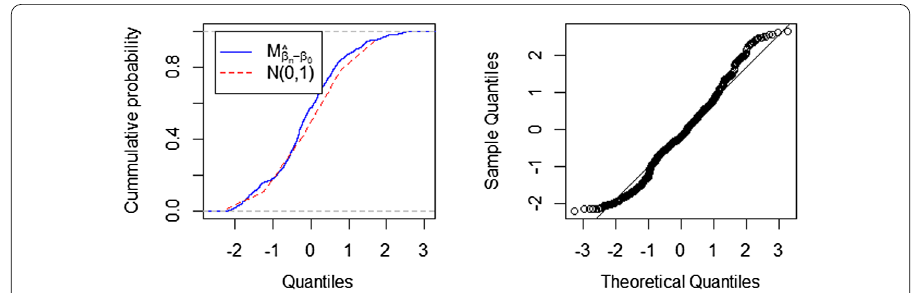
Figure 2 A comparison fitted distribution functions of M ˆ n =